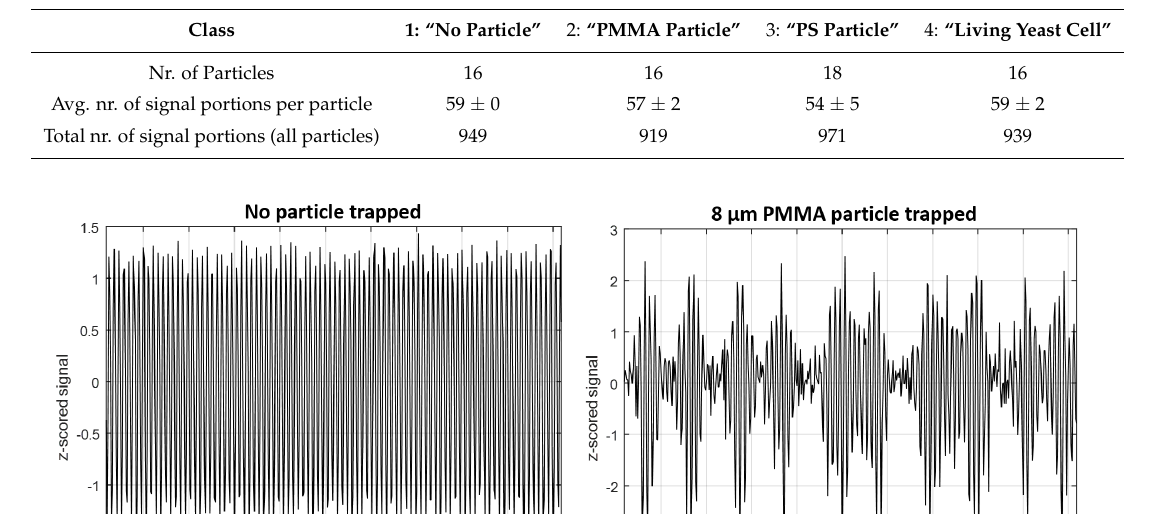
Table 2. Dataset characterization. Each sample/instance corresponds to each 2 s back-scattered signal. In the case of class 1/“no particle” condition, each particle ID corresponds to different acquisitions made with no particle in front of the fiber tip. Nr—number. Avg—average.